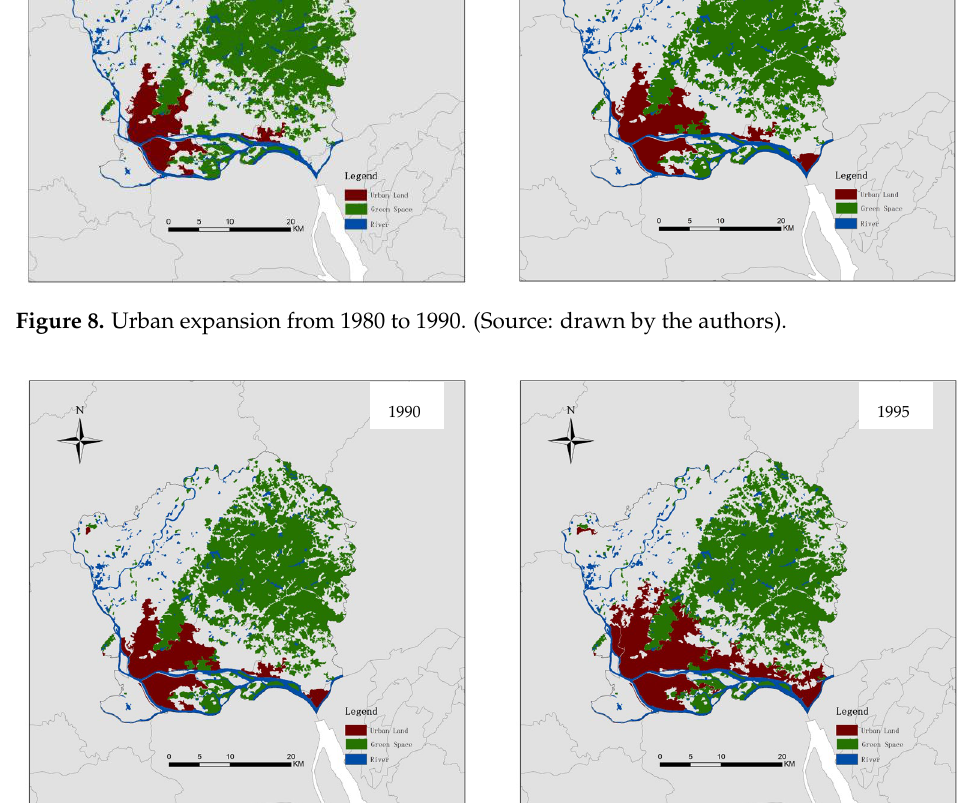
Figure 9. Urban expansion from 1990 to 1995. (Source: drawn by the authors).